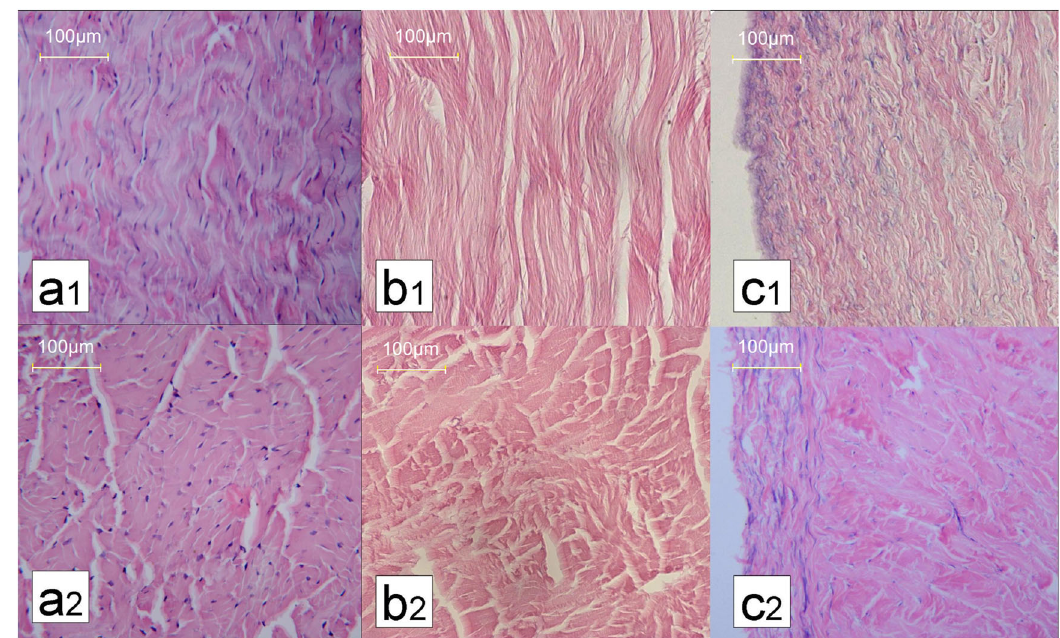
Fig. 5 Hematoxylin and eosin (H&E) staining of specimens after decellularization. a 1, a 2 Longitudinal sections and cross sections of patella tendons (PT); b 1, b 2 longitudinal sections and cross sections of Fig. 6 Scanning electron microscopy of specimens after decellularization. a Cell debris (white arrow) seen on the cross section of normal freeze-dried patella tendons (PT) (magni fi cation ×300); b no cell debris are seen on the acellular aponeurosis-discission ligament (AADL), but the interspaces between the collagen fi bers are increased; c the normal PT collagen fi brils exhibit a spiral shape (magni fi cation ×20,000); d the AADL collagen fi bril structure shows no change compared to that of the